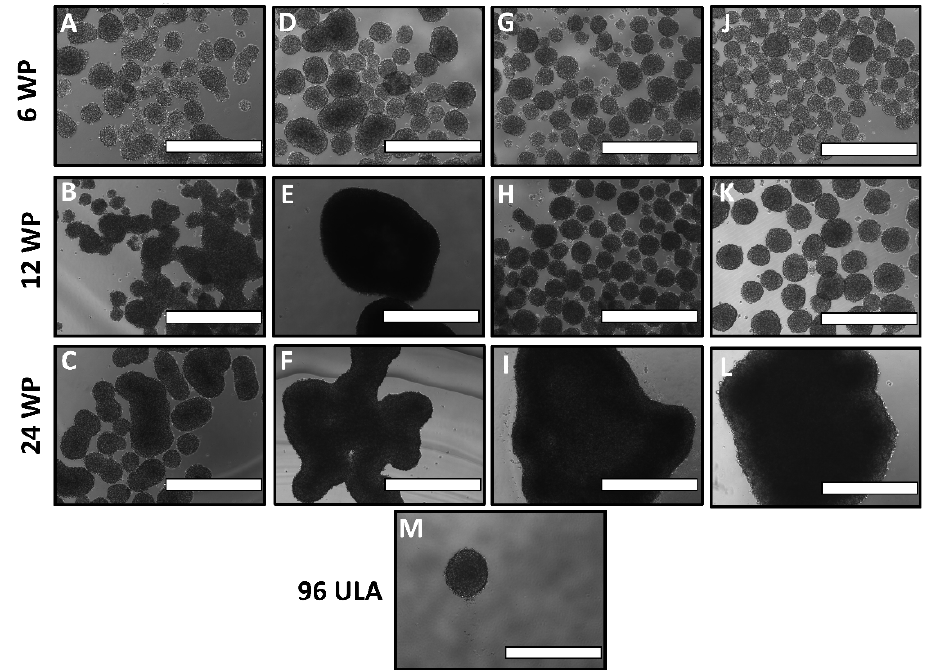
Figure 4. Optimization of well plate size and rotation speed for ES-2 spheroid production. ( A – C ) ES-2 spheroids were grown for 72 h in static 6, 12 and 24 WPs, respectively. ( D – F ) Spheroids grown under rotating cell culture at 100 rpm for 72 h in 6, 12 and 24 well plates (WPs), respectively. ( G – I ) Spheroids grown under rotating cell culture at 120 rpm for 72 h in 6, 12 and 24 WPs, respectively. ( J – L ) Spheroids grown under rotating cell culture at 140 rpm for 72 h in 6, 12 and 24 WPs, respectively. ( M ) Static spheroid grown in a round-bottom 96 WP for 72 h. Scale Bar: 1000 µm.